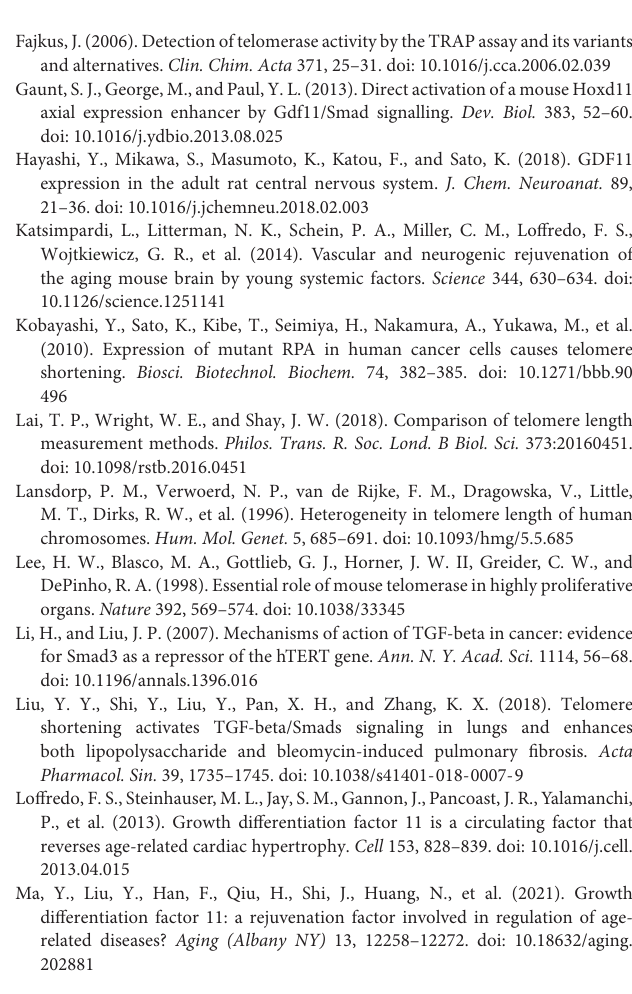
Supplementary Table 1 | Details of statistical methods, results, and sample sizes of all figures are